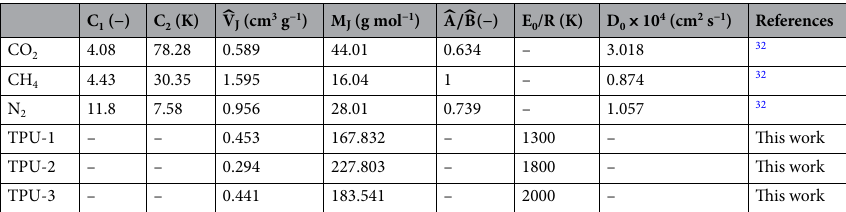
Table 2. The E-VSD model parameters for the pure gases and